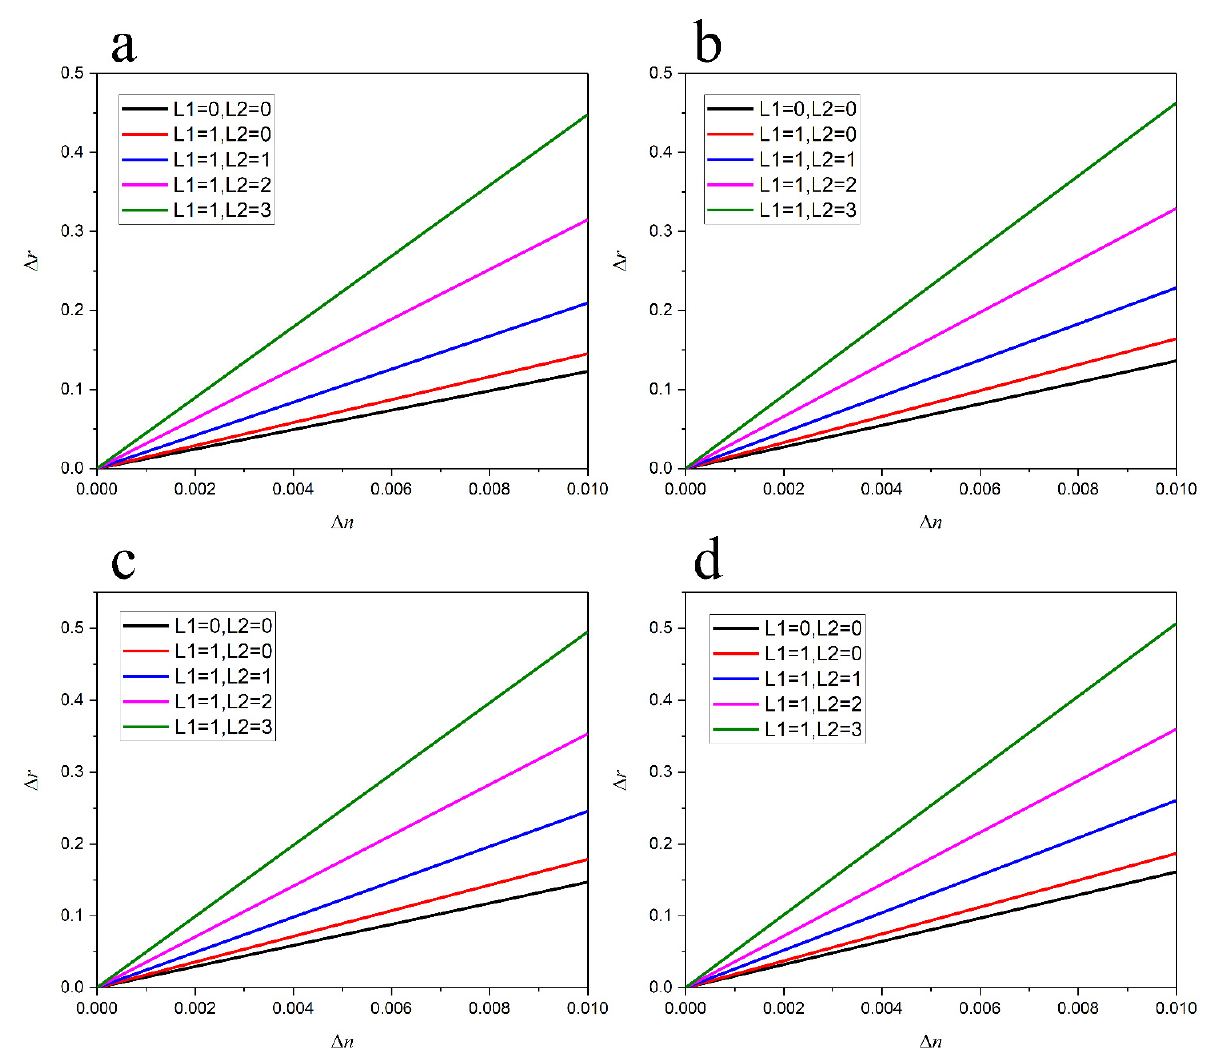
Figure 6. Detection sensitivity of the SPR sensor effect with MoS 2 thickness. ( a – d ) show the sensing performance analysis of the SPR sensor with Ag film thicknesses of 40 nm, 41 nm, 42 nm, and 43 nm, respectively. L1 is the number of layers of graphene, and L2 is the number of layers of MoS 2 . The introduction of graphene can improve the detection sensitivity of the